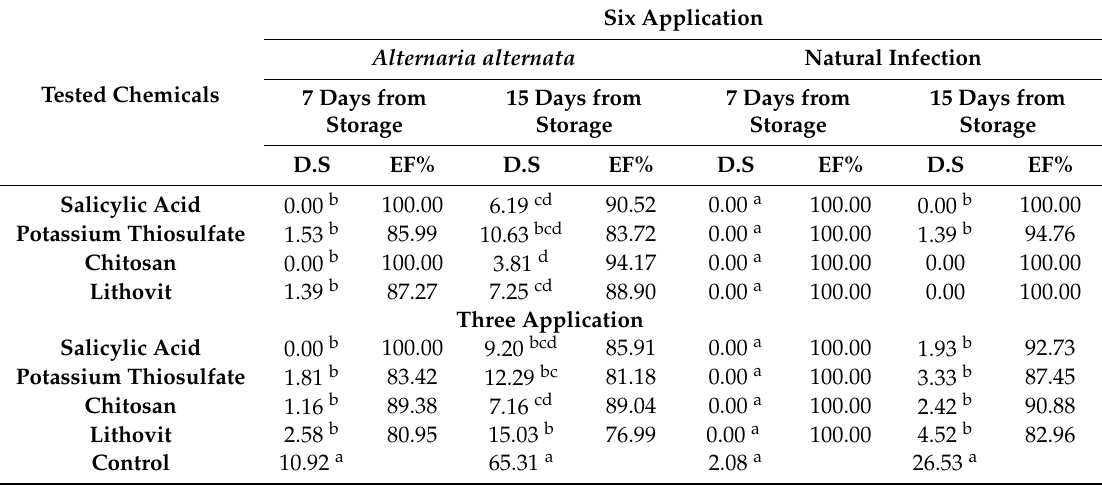
Within each column (for six and three applications), the same letters indicate no significant di ff erence among treatments at ( p < 0.05). EF%: e ffi cacy as a percentage. D.S: disease severity. Control was infected with A. alternata or without infection and un-treated. Table 5. The e ff ect of tested chemicals as pre-harvest foliar applications on tomato black rot during storage under cold conditions during season